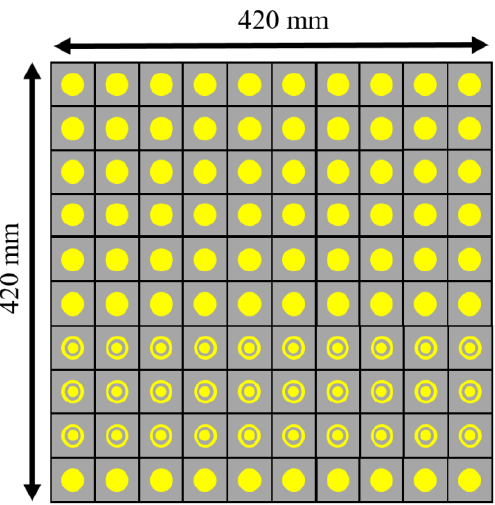
Figure 8. 10×10-unit cell array with combined structure.